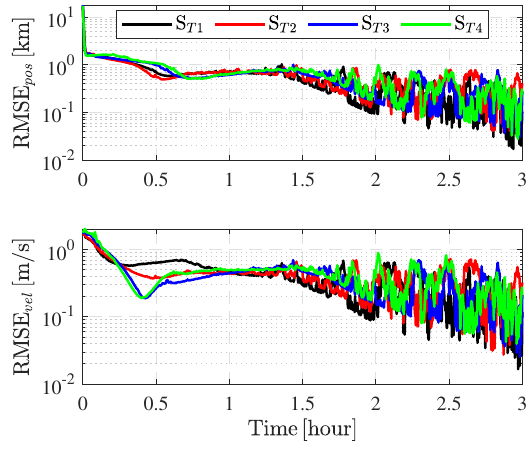
Figure 6. Time history of the RMSEs. Table 4. Mean RMSE of the Monte Carlo